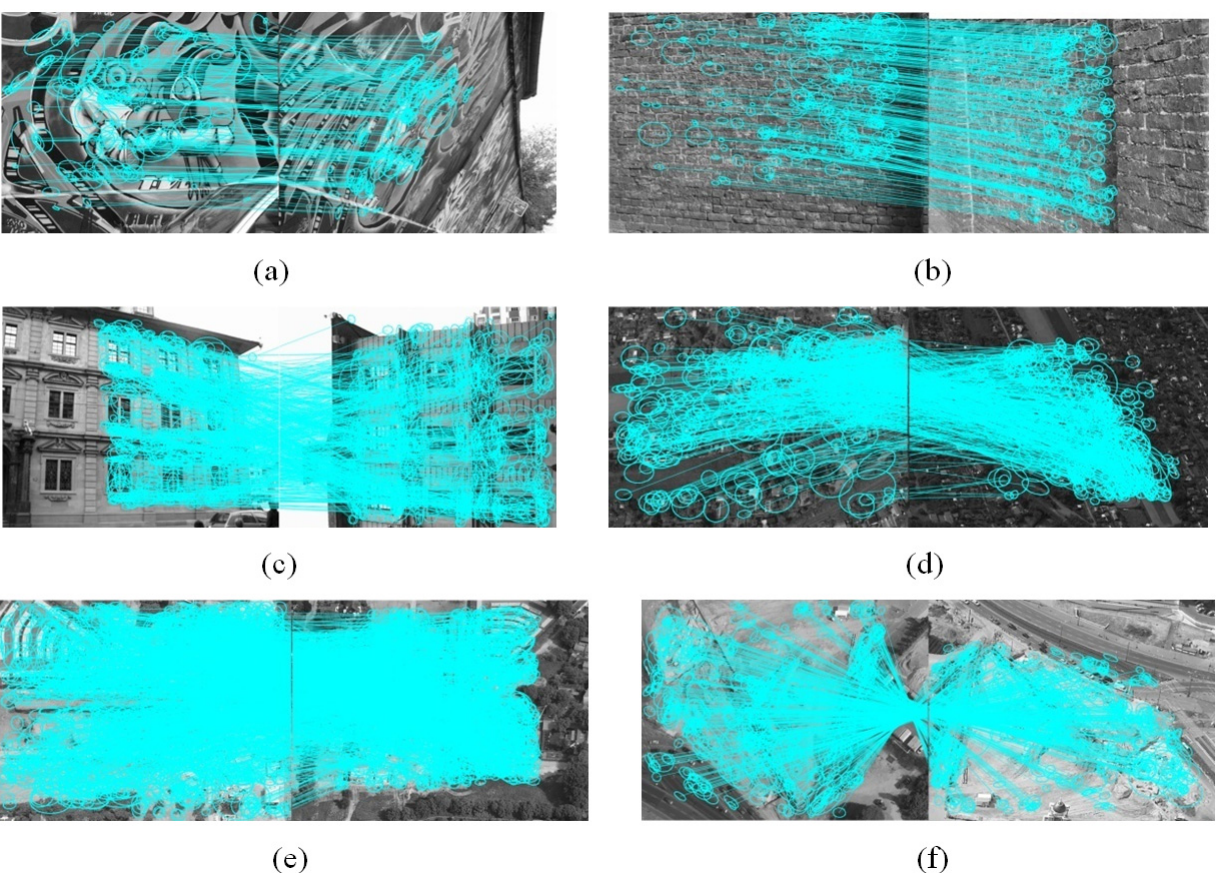
Figure 8. ( a )–( f ) Matching results of our approach on a group of stereo pairs. The ellipses represent the regions matching around each feature point. Lines represent the matches.